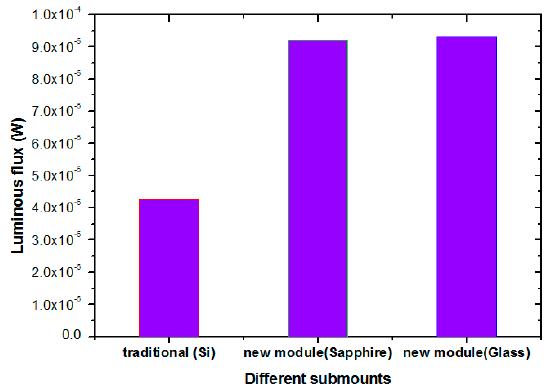
Figure 2. Comparison of luminous flux with different substrates under different mounting technologies.